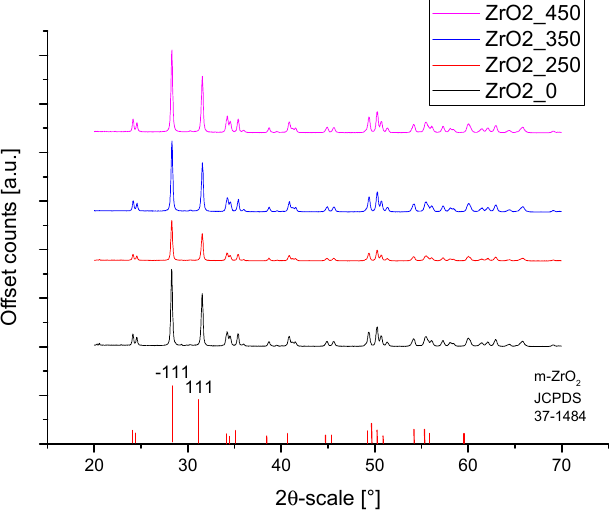
Figure 1. XRD patterns of heat-treated and APTES surface modified zirconia.